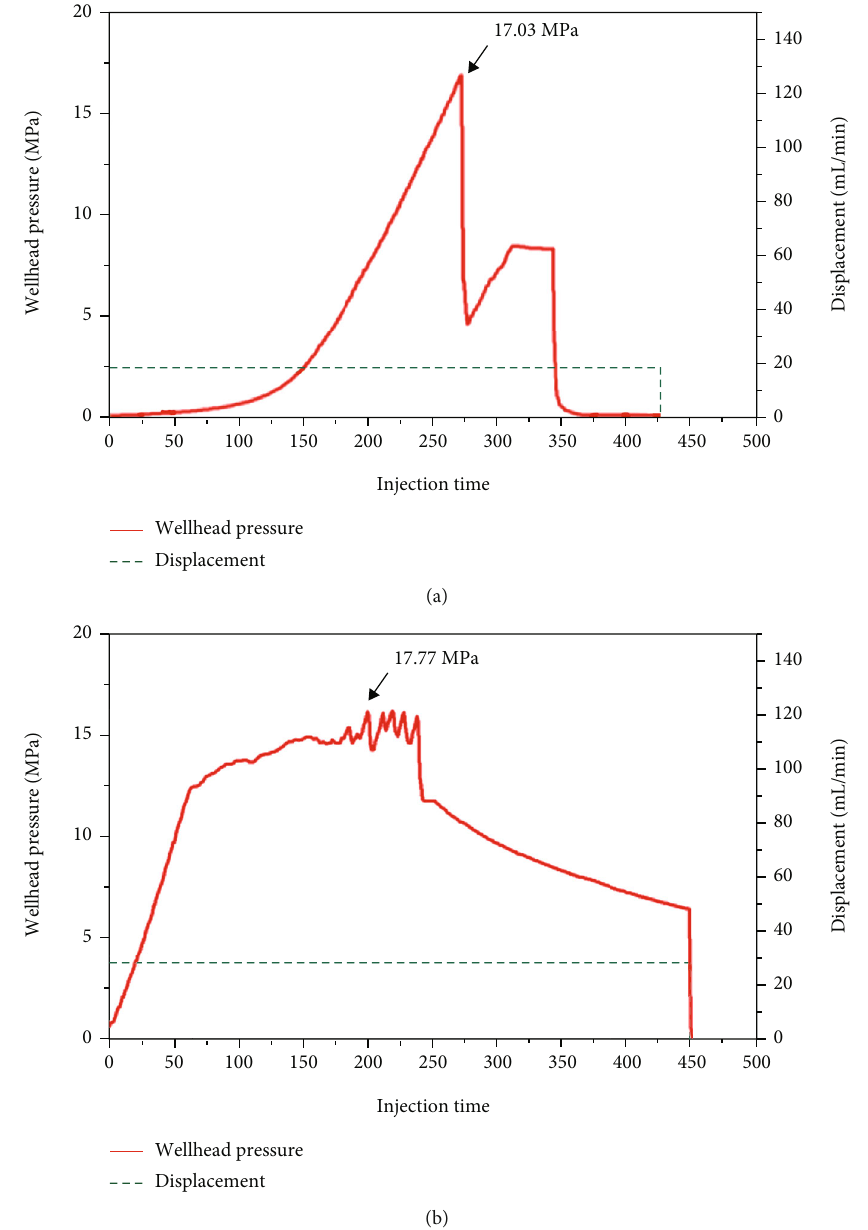
Figure 7: Injection pressure curve of di ff erent pumping rates. (a) Sample 4#. (b) Sample